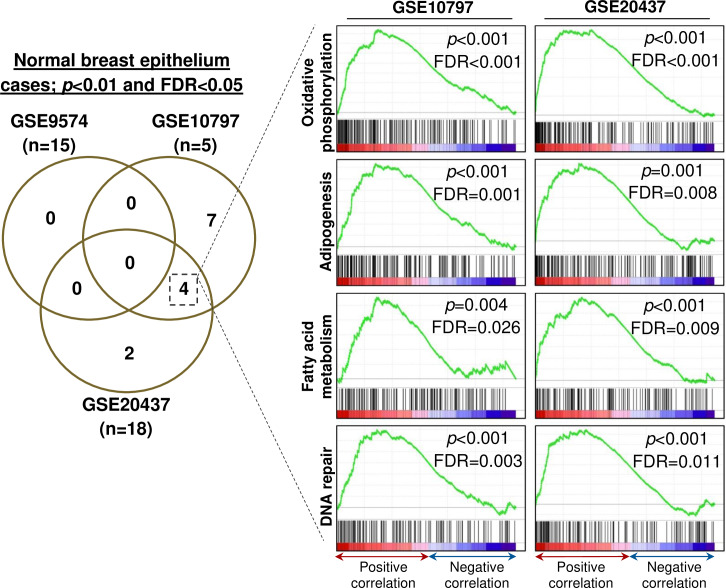
Consensus gene sets (Hallmark collection of the MSigDB) enriched according to TRPM4 expression (219360_s_at) in three independent normal breast epithelium datasets (GSE9574, GSE10797, GSE20437).